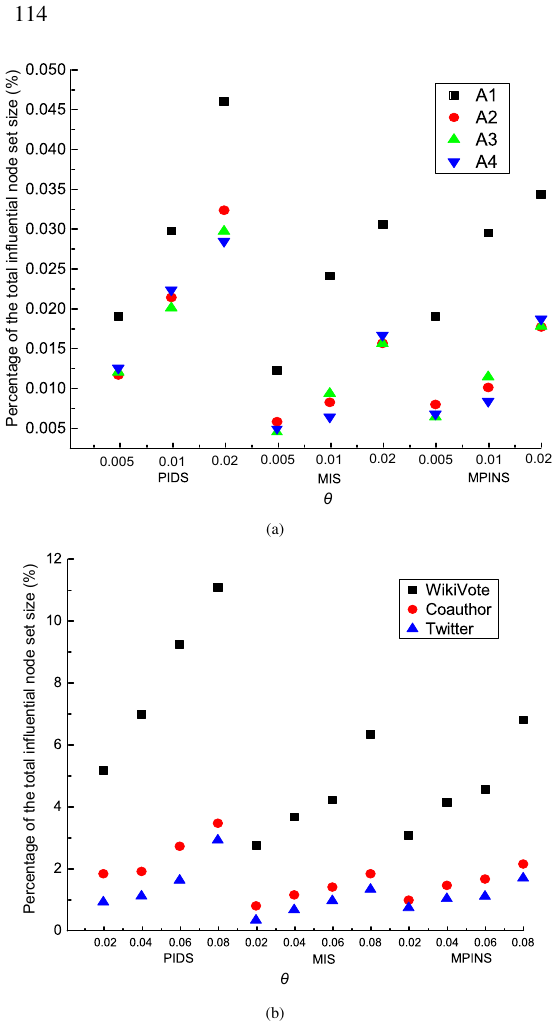
Fig. 13 Percentage of the total influential node set size in (a) Amazon co-purchase data sets and (b) WikiVote, Coauthor, and Twitter data sets.